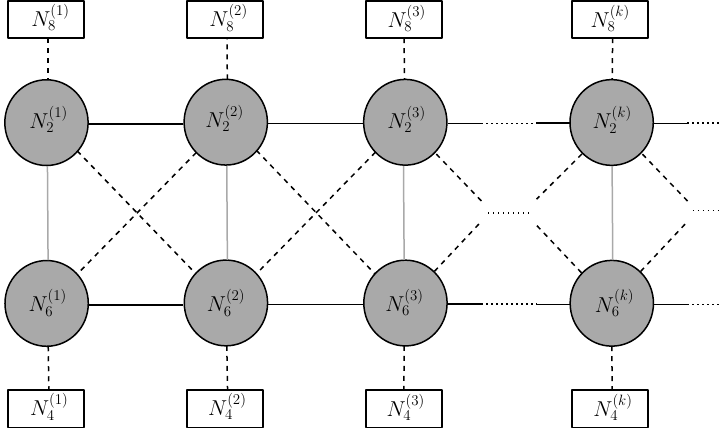
Figure 1 . Generic quiver (cid:12)eld theory whose IR is holographic dual to the solutions reviewed in this section. The solid black line represents a (4,4) hypermultiplet, the grey line a (0,4) hypermul- tiplet and the dashed line a (0,2) Fermi multiplet. The degrees of freedom at each node are (4,4) vector